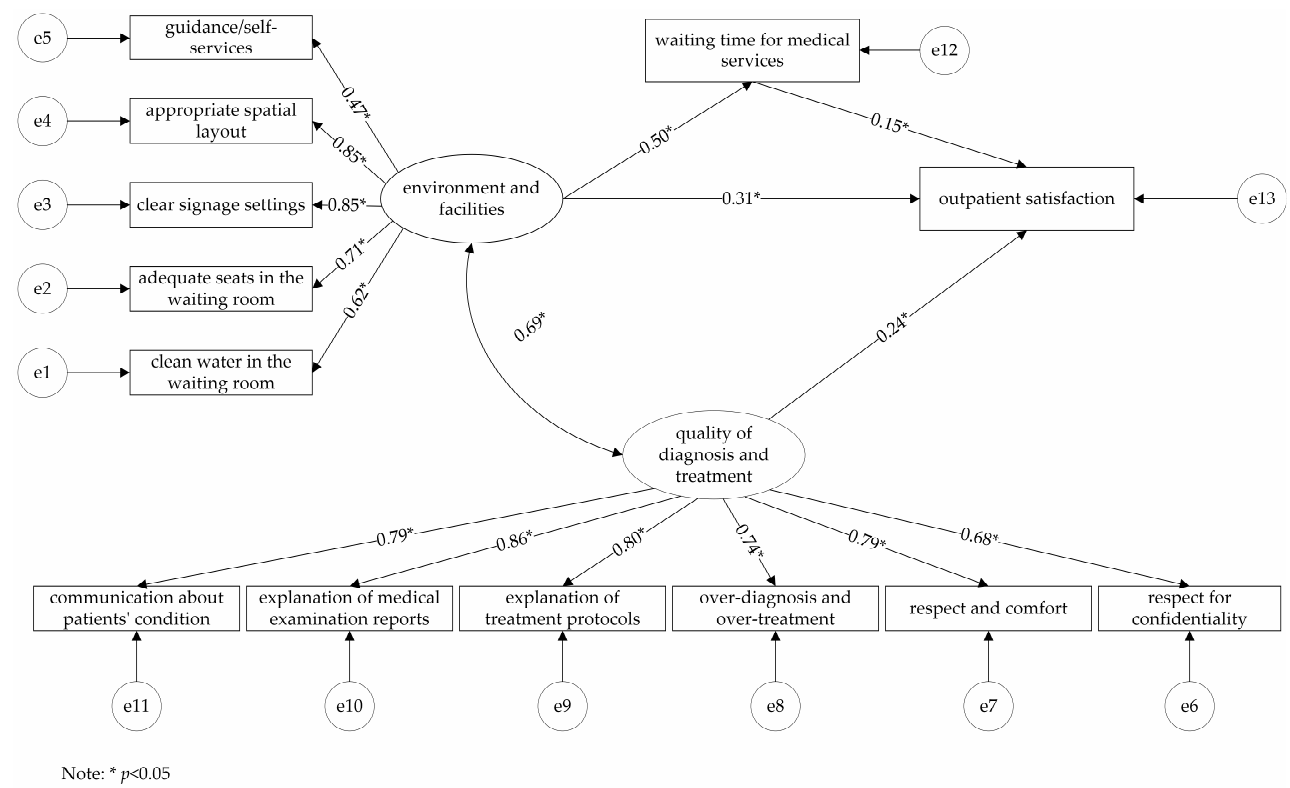
Figure 2. The corrected model of outpatient satisfaction in provincial tertiary hospitals.